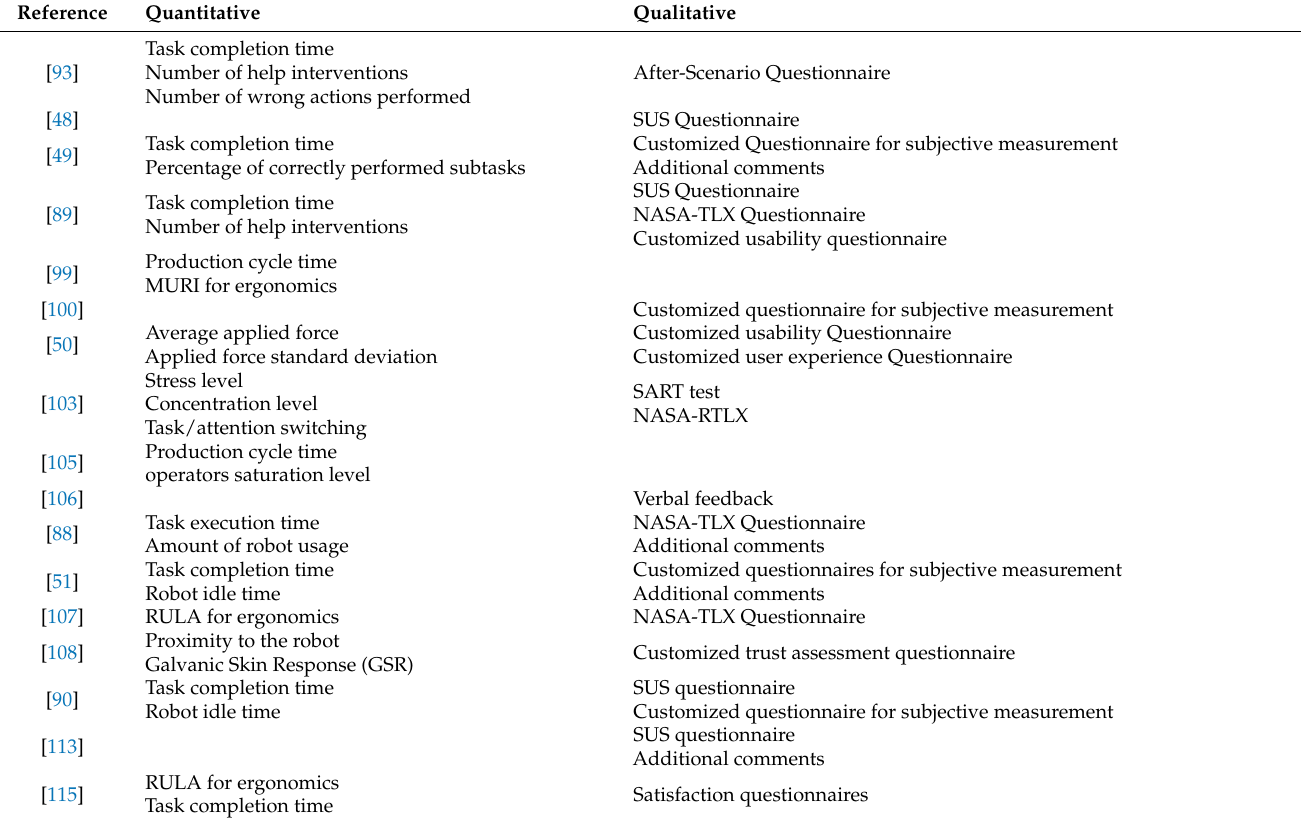
Table 15. Evaluation